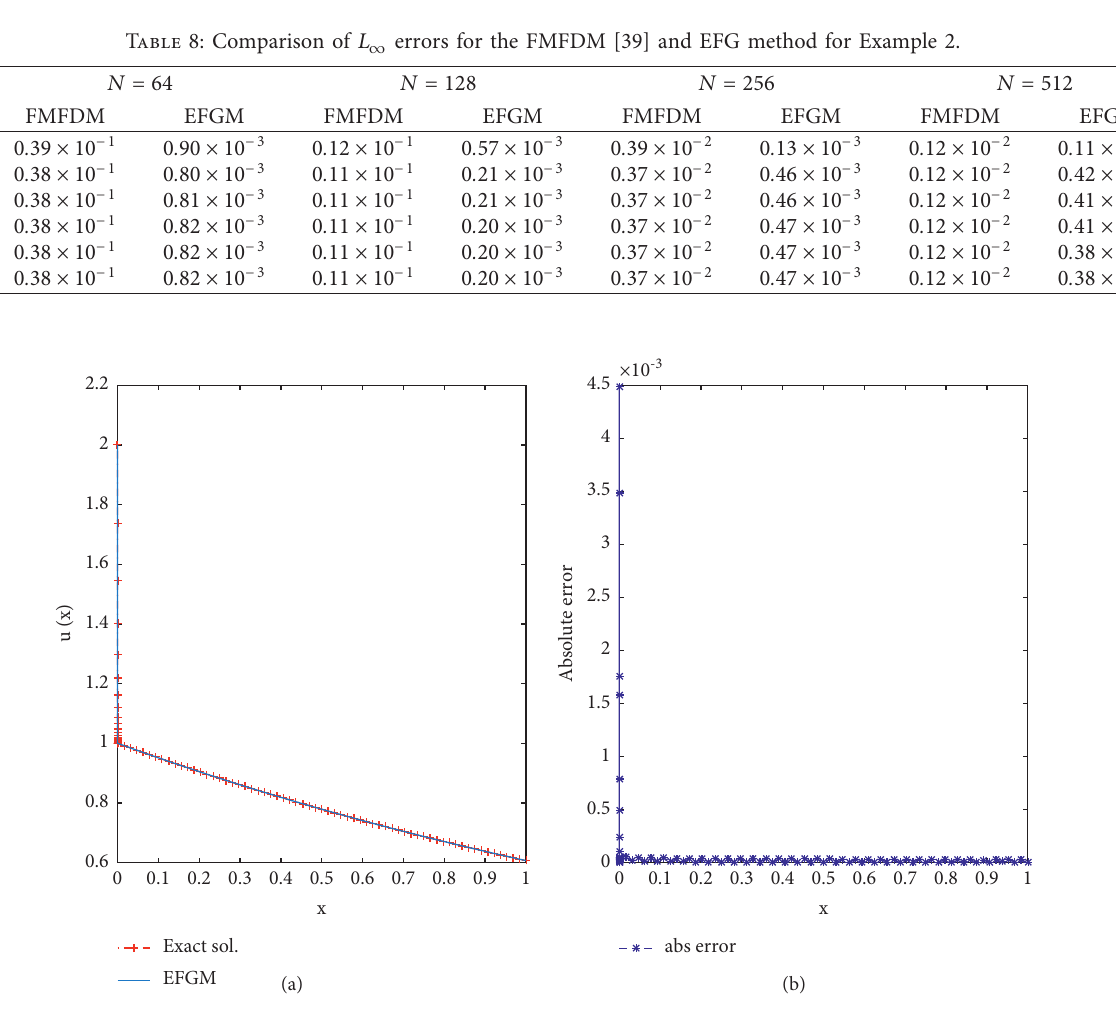
Figure 5: (a) Exact and EFG solution plot. (b) Pointwise absolute error plot for ϵ � 2 − 7 and N � 128 for Example 2 using linear basis and cubic weight